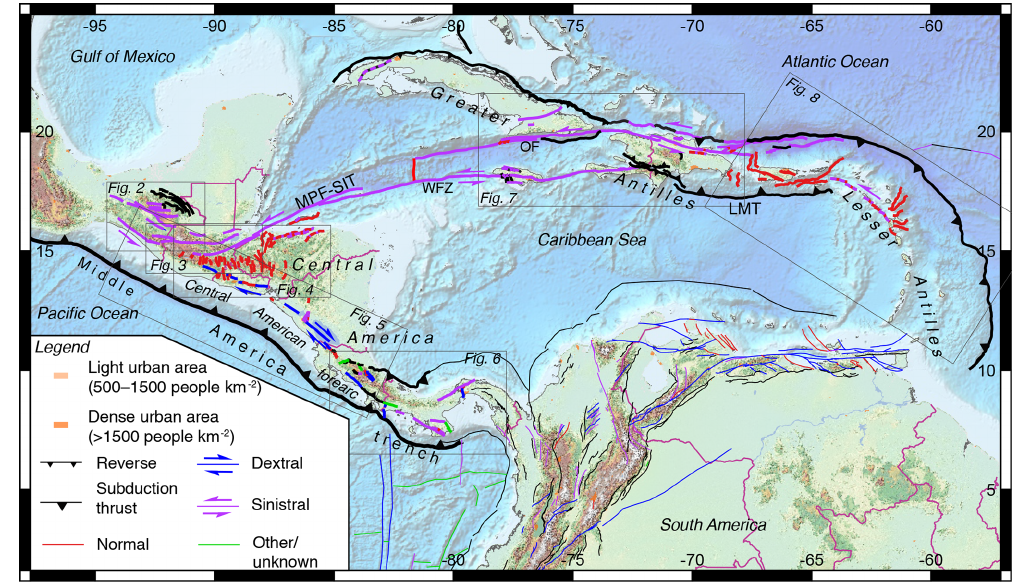
Figure 1. Active faults of the Caribbean and Central America. Faults with thicker lines are in the CCAF-DB, while faults with thinner lines in South America are from the SARA (https://sara.openquake.org/, last access: 23 March 2020) and ATA (Veloza et al., 2012) datasets. LMT is the Los Muertos trough. MPF–SIT is the Motagua–Polochic fault and Swan Islands transform fault. OF is the Oriente fault. WFZ is the Walton fault zone. Names given in italicized text are geographic features, while those in regular text are structural features. Population data are from © WorldPop (Sorichetta et al., 2015). Base topography is from the Shuttle Radar Topographic Mission (Farr et al., 2007) (in the public domain), and coastlines are from Wessel and Smith (1996), based on public-domain